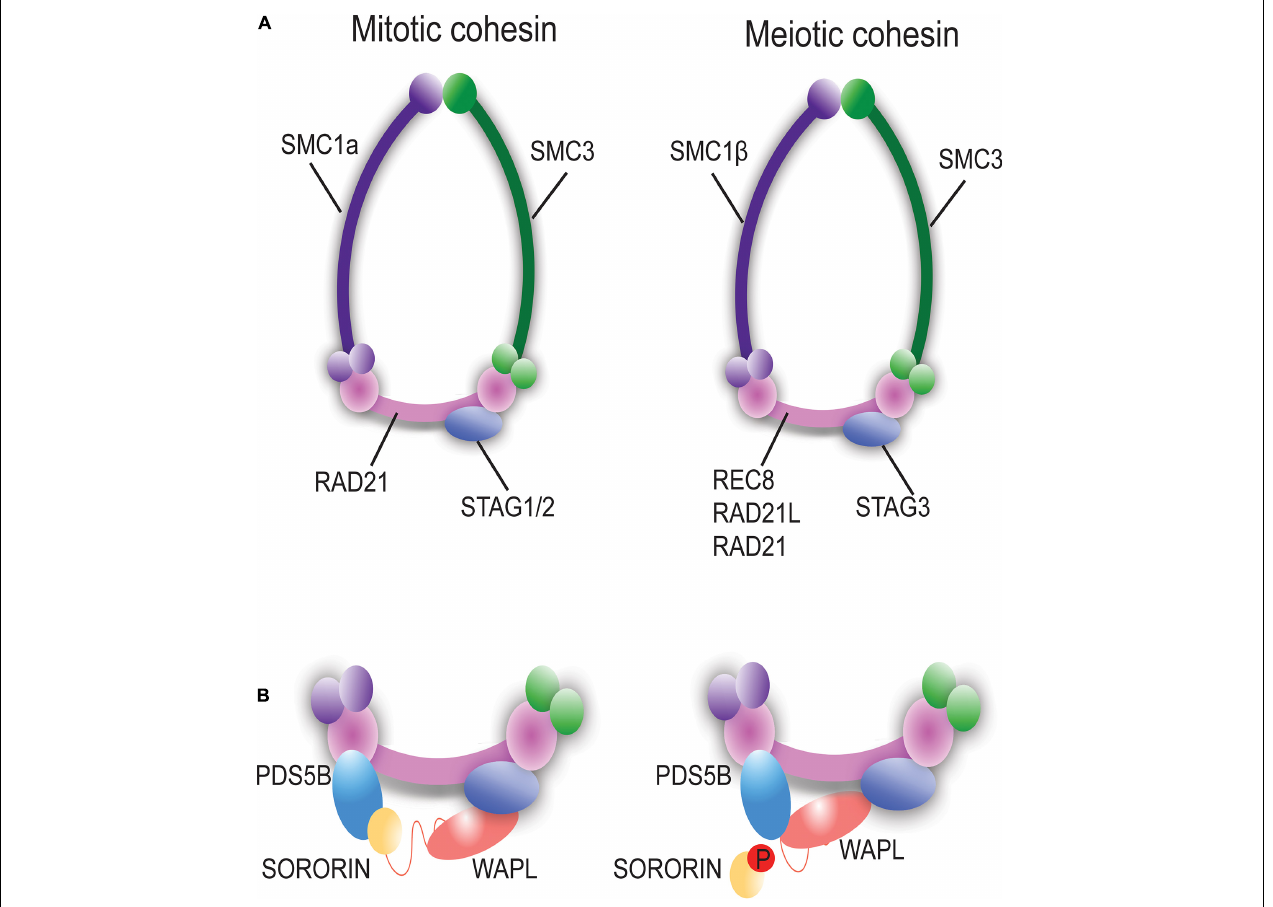
FIGURE 2 | Mitotic vs. Meiotic Cohesin ring components and associated proteins. (A) Schematic representation of mitotic and meiotic cohesin complexes. The meiosis-specific cohesin ring proteins are SMC1 β , RAD21L, REC8, and STAG3. (B) PDS5B, WAPL, and Sororin are associated with the cohesin complex and regulate the dynamic interaction of cohesin with chromatin. Phosphorylation of Sororin dissociates it from the cohesin ring permitting interaction of WAPL with PDS5B to open the of the cohesin ring via the prophase